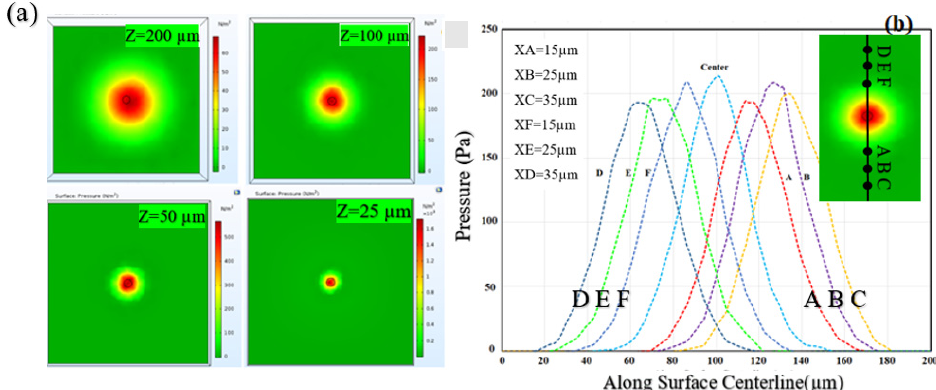
Figure 8. Airflow on a flat surface with a dimension of 200 µm × 200 µm. Airflow from a circular microhole with R = 5 µm and different vertical distances. ( a ) Airflow velocity of 10 m/s, R = 5 µm, Z varied from 25 µm to 200 µm. ( b ) Pressure profiles along the centerline of the surface.